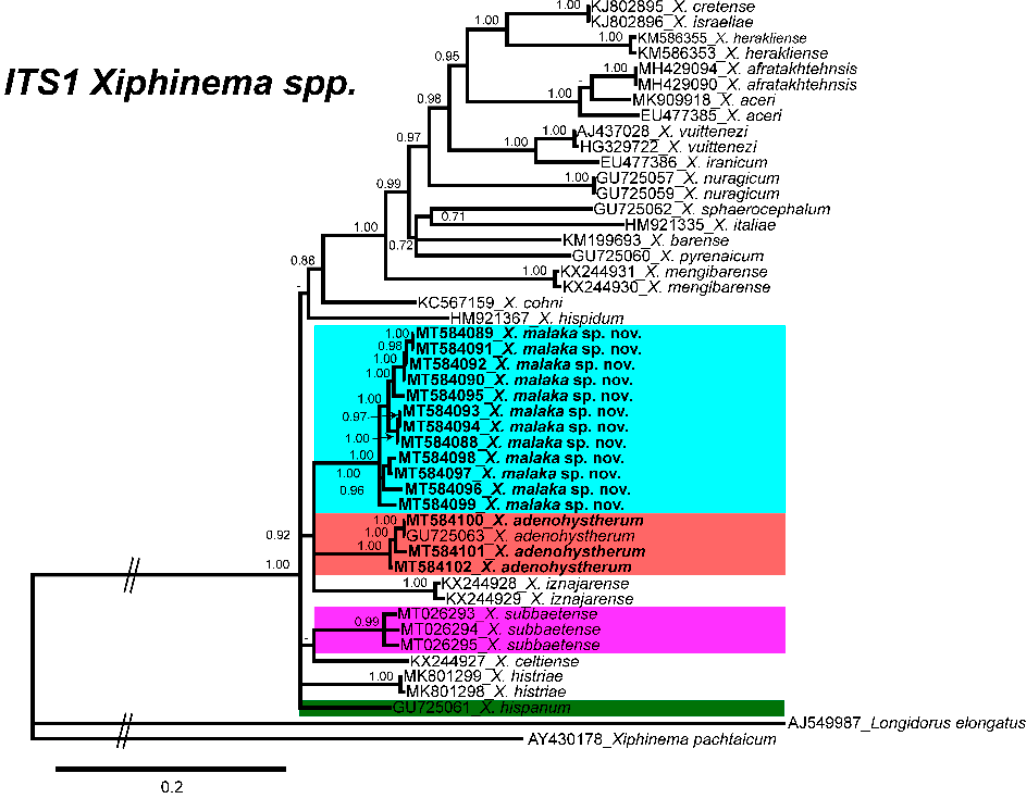
Figure 4. Phylogenetic relationships of Xiphinema malaka sp. nov. within the genus Xiphinema . Bayesian 50% majority-rule consensus trees as inferred from ITS1 sequence alignments under transition model with a proportion of invariable sites and a rate of variation across sites (TIM2 + I + G). Posterior probabilities more than 70% are given for appropriate clades. Newly obtained sequences in this study are in bold letters, and each colour is associated with each species of the complex.